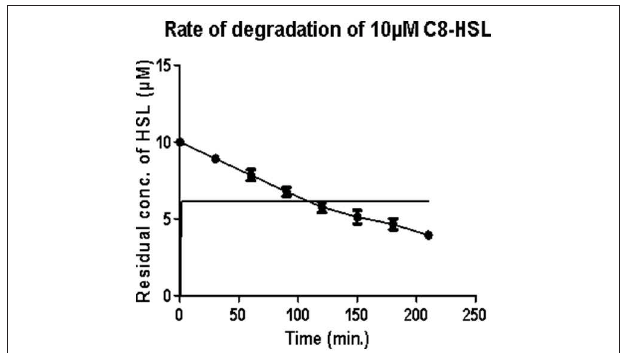
FIGURE 1 | Estimation of residual concentration of homoserine lactones (HSL) to determine the time dependent activity of AiiA. The concentration of C8-HSL was calculated in µ M. Each value on the graph represent three independent events in duplicates.